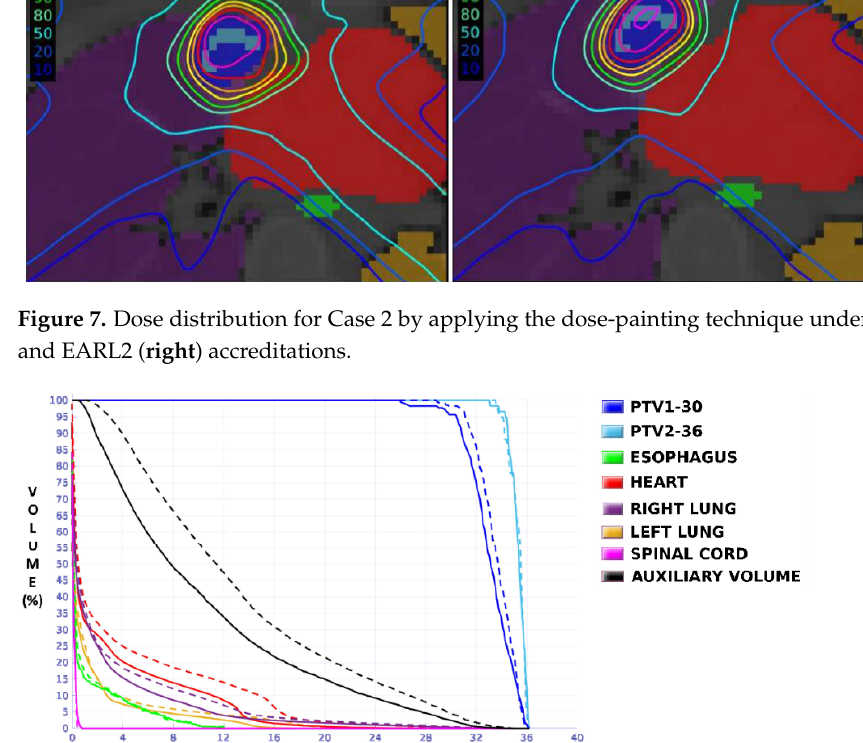
Figure 8. DVHs of the planning solutions for Case 2 under EARL1 (dashed lines) and EARL2 (solid lines) accreditations on the volumes generated with EARL2.